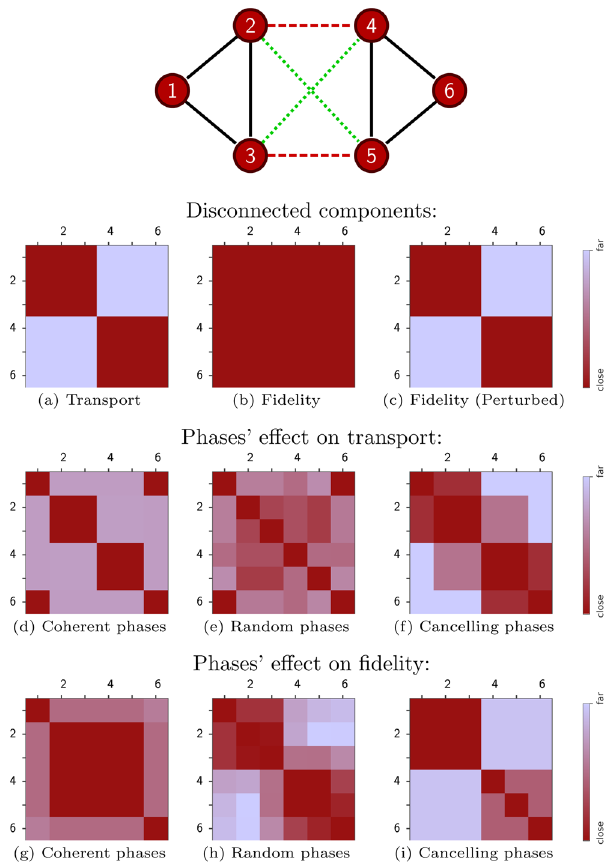
FIG. 2. Simple quantum network — a graph with six nodes. Each solid line represents transition amplitude H ij ¼ 1 . For dashed and dotted lines, the transition amplitude can be either zero (a) – (c) or the absolute value is the same j H ij j ¼ 1 but phase is (d),(g) coherent (all ones), (e),(h) random exp ð i φ k Þ for each link, or (f),(i) canceling (1 for dashed red and − 1 for dotted green). Plots show the node closeness for both methods based on transport and fidelity (only the long-time averages are consid- ered). [In plots (g) – (i) we use a perturbed Hamiltonian to solve the degeneracy of the eigenvalues; this explains the nonsym- metric closeness in